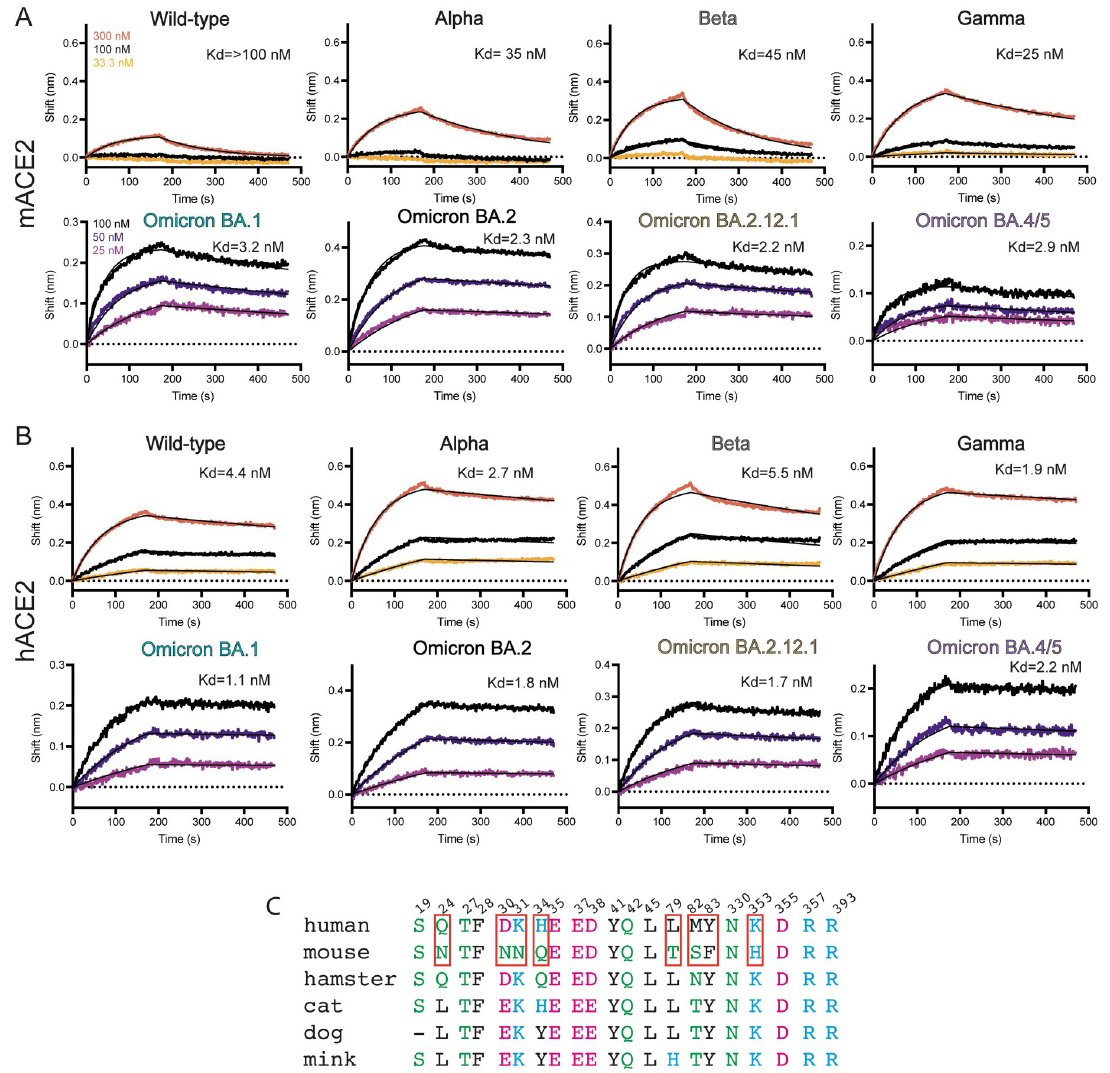
Fig 1. mACE2 and hACE2 binding to variants of concern. (A) BLI binding assays of captured dimeric mouse ACE2 versus various concentrations of Spike variants of concern. Data curves are colored by concentration and the black line indicates the 1:1 fit of the data. (B) BLI binding assays of captured dimeric human ACE2 versus various concentrations of Spike variants of concern. Data curves are colored by concentration and the black line indicates the 1:1 fit of the data. (C) Sequence alignment of human ACE2 with mouse ACE2 and other selected species. Red boxes highlight critical differences between human and mouse ACE2